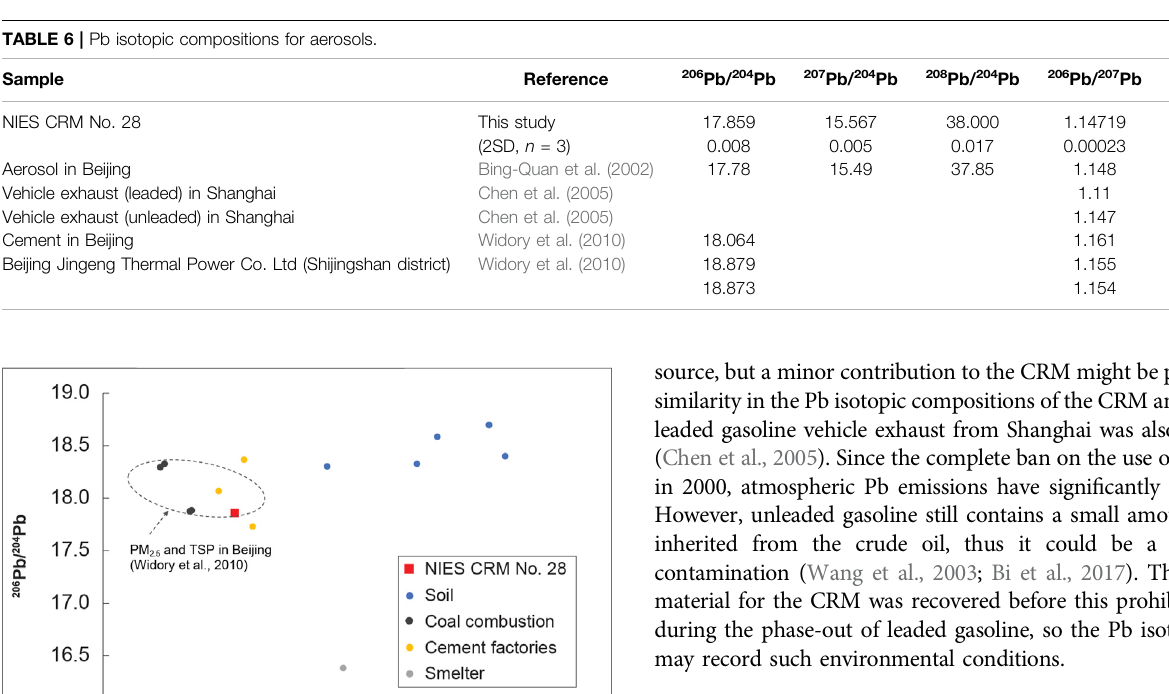
Frontiers in Environmental Chemistry |